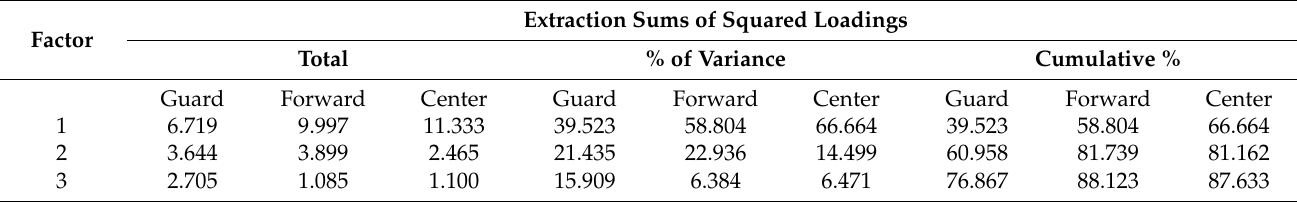
Table 2. Saturated factors with the structure indicators of the explained